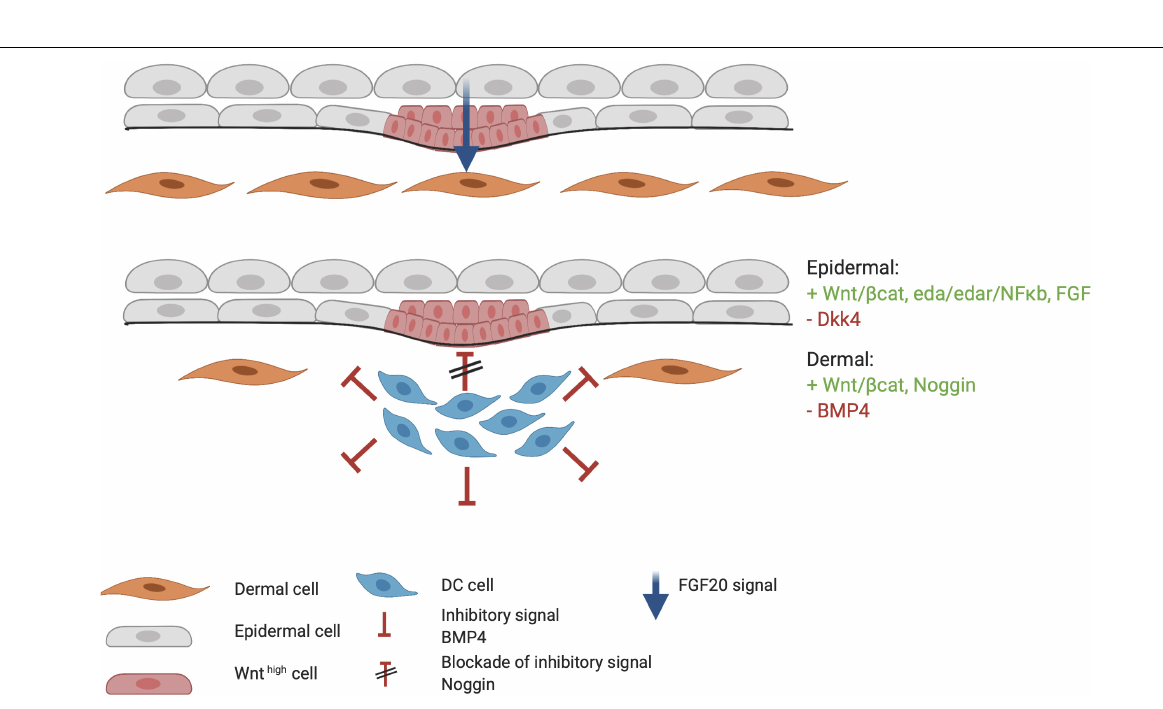
Frontiers in Cell and Developmental Biology |